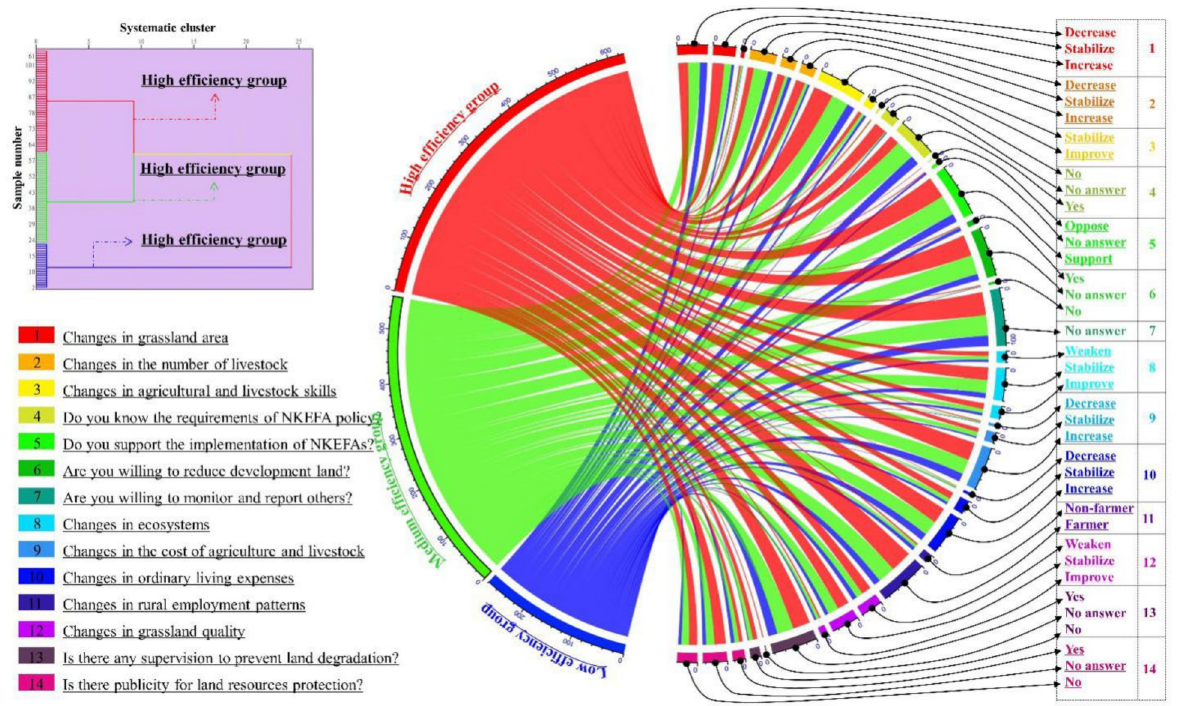
Figure 5. Resident reflection of questionnaire. The NKEFA policy increased the living costs of residents, but ecological improvement was not obvious. The high-efficiency group had a better evaluation of this policy than the low-efficiency